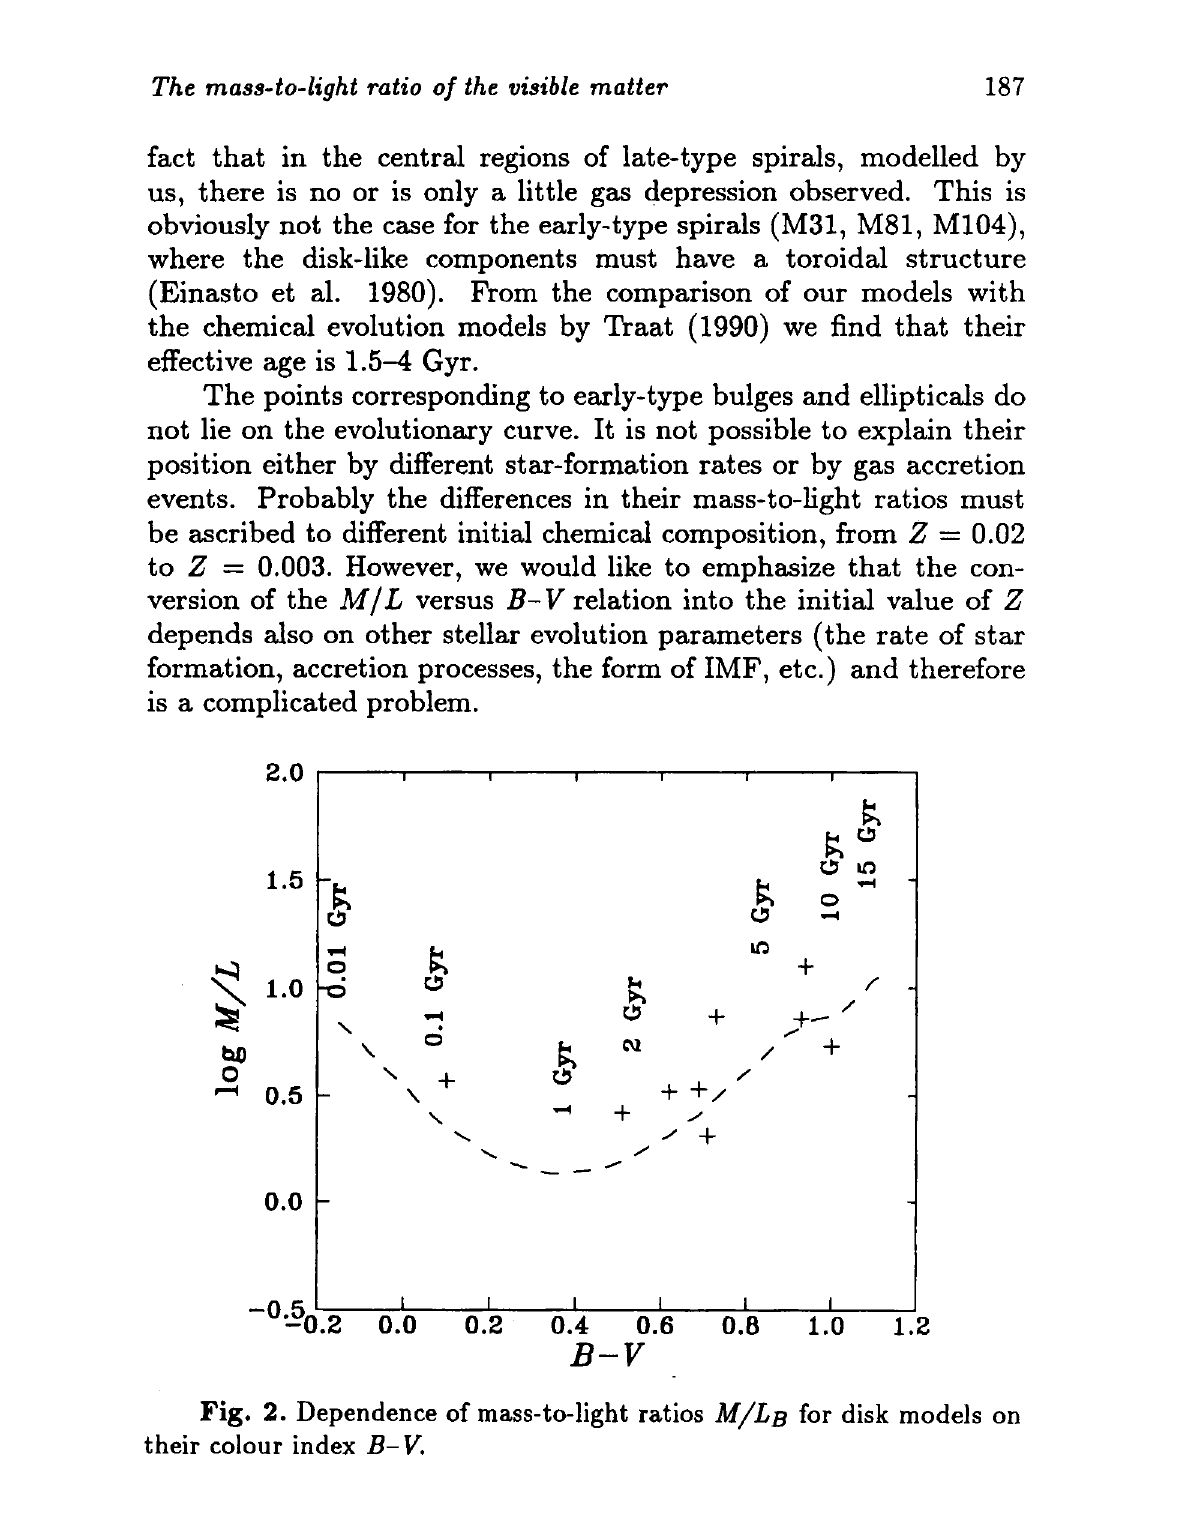
Fig. 2. Dependence of mass-to-light ratios M/Lg for disk models on their colour index